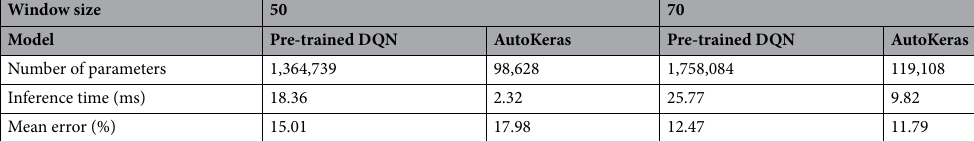
Table 4. Benchmarking results of pre-trained DQN and optimised model generated using AutoKeras on the NCBI Virus Data Hub influenza dataset. The computations were performed on the NVIDIA Jetson Nano Developer Kit with floating point